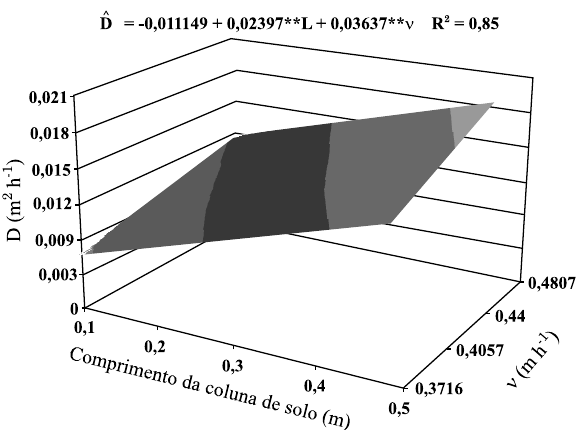
Figura 4. Estimativas do coeficiente de dispersão- difusão (D) de potássio num Neossolo Quartzarênico órtico (RQo), em função de colu- nas de solo com 0,10 a 0,50 m de comprimento (L) e de velocidades de escoamento da solução (v) de 0,37 a 0,48 m h -1 . **: significativo a 1 % pelo teste